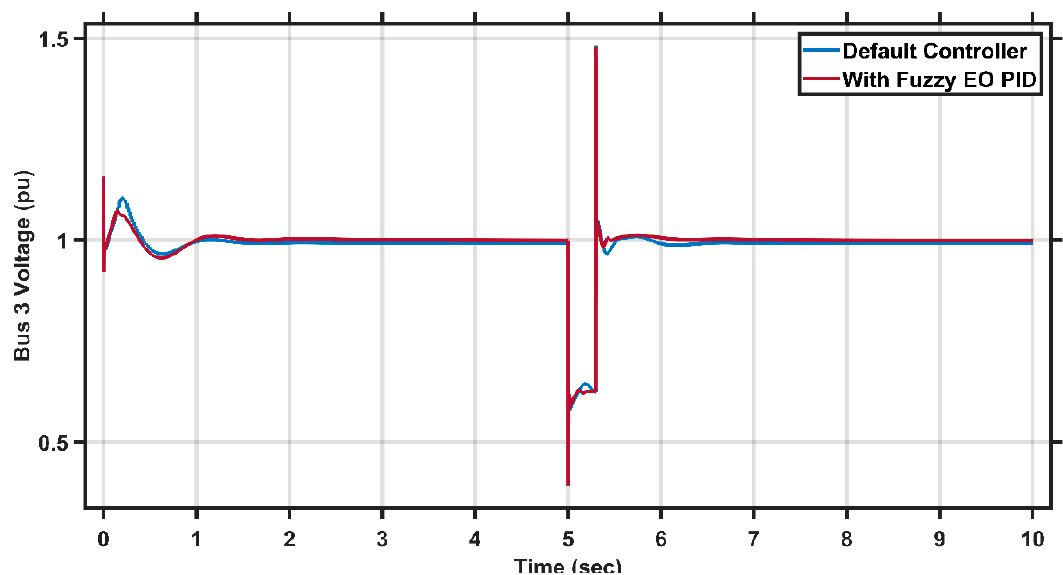
Figure 23. Bus 3 voltage at faulty condition for the IEEE 9-bus system.